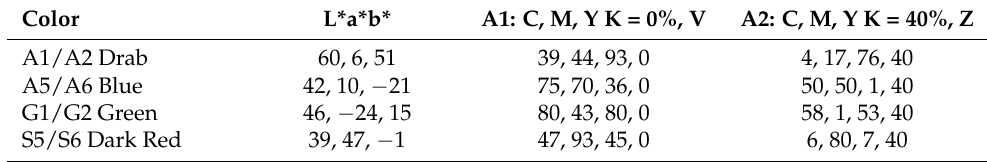
Figure 10. Four pairs of twin colors and dyes with K = 40%. Table 2. Formulations for the colors and dyes of four twin